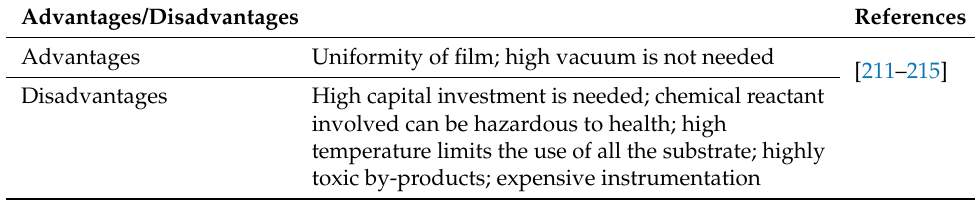
Table 15. Some of the significant advantages and disadvantages of chemical vapour deposition are mentioned in this